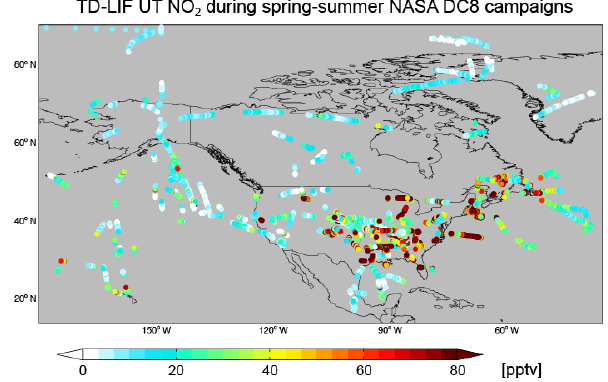
Figure 2. NASA DC8 upper troposphere NO 2 over North Amer- ica in spring–summer (March–August). Observations are from the thermal-dissociation laser-induced fluorescence (TD-LIF) instru- ment at 450–280hPa, 11:00–16:00LT, and without stratospheric influence. Campaigns include the Intercontinental Chemical Trans- port Experiment – North America Phase A (INTEX-A) in June– August 2004 (Singh et al., 2006), Phase B (INTEX-B) in March– May 2006 (Singh et al., 2009), Arctic Research of the Composi- tion of the Troposphere from Aircraft and Satellites (ARCTAS) in March–April and June–July 2008 (Jacob et al., 2010), Deep Con- vective Clouds and Chemistry (DC3) in May–June 2012 (Barth et al., 2015), and Studies of Emissions, Atmospheric Composition, Clouds and Climate Coupling by Regional Surveys (SEAC 4 RS) in August 2013 (Toon et al., 2016).